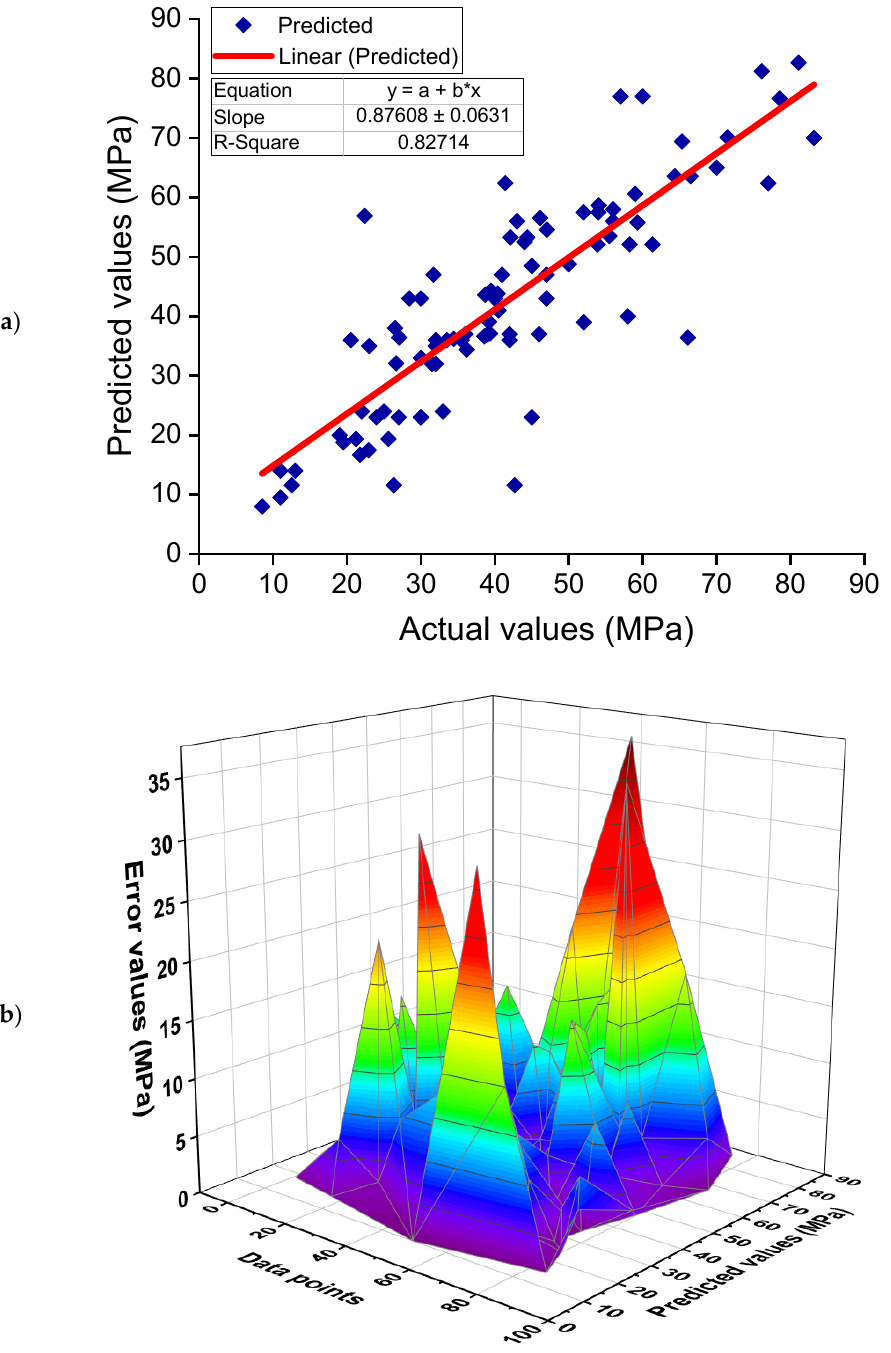
Figure 7. Decision tree model: ( a ) correlation between experimental and estimated results; ( b ) dispersal of predicted and error values.